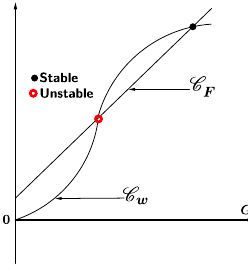
Fig. 8. There exist two savanna equilibria but one is stable and the other is unstable.